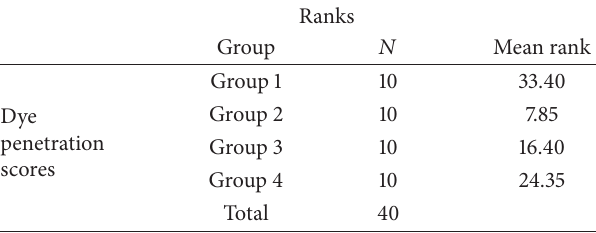
Table 2: Mean of dye penetration scores in different groups using Kruskal-Wallis test.